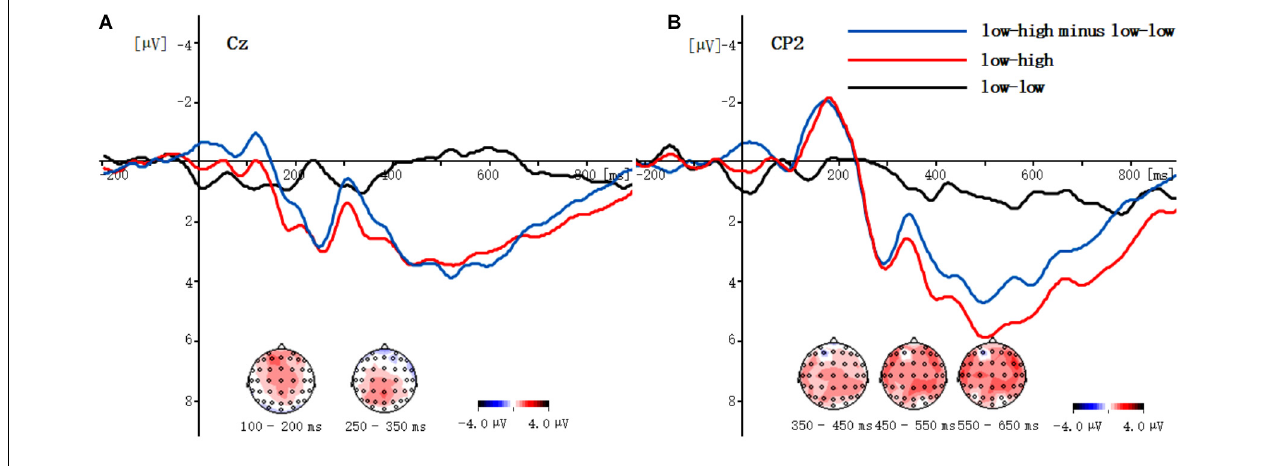
FIGURE 3 | The difference waves in Cz (A) and CP2 (B) (“low-high” task minus “low-low” task) and the voltage topographic maps.